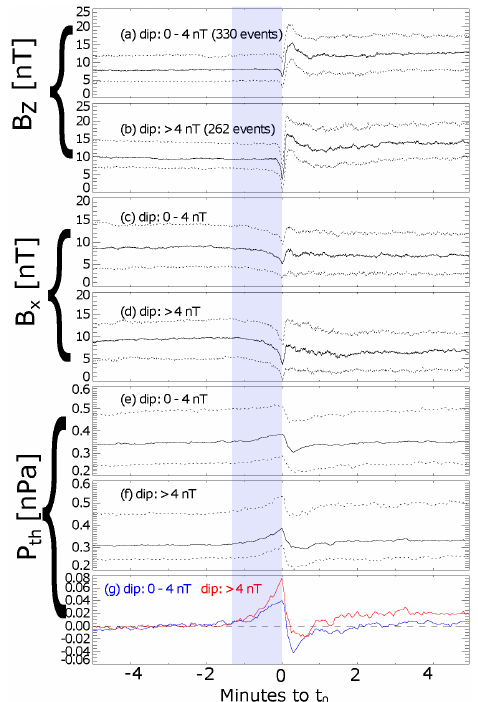
Figure 2. Superposed epoch analysis of ( a and b ) magnetic field B z for both DF with small dip ( B z, dip from 0 to 4nT) and large dip ( B z, dip >4nT); (c and d) magnetic field B x for both DF groups. We reversed the sign of B x for events with B x, 0 < 0; ( e and f ) plasma pressure for both DF groups and (g) plasma pressure for both DF groups subtracted with their average values of the time range from t 0 –4min to t 0 –3min. The three curves in each panel denote the up- per quartile (dotted), median (solid), and lower quartile (dotted) of the superposed